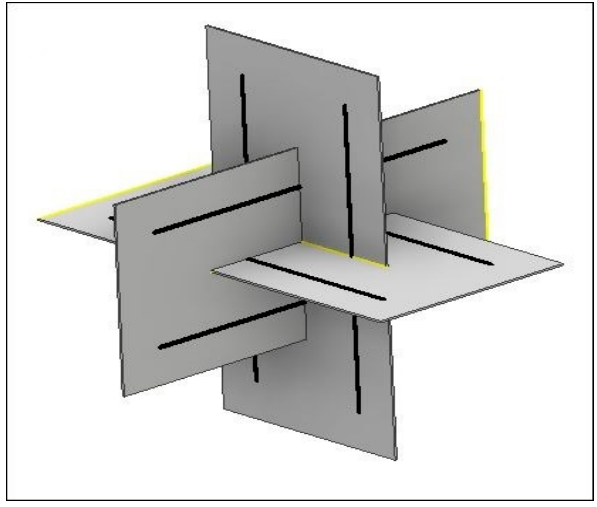
Figure 2. The struts of a tensegrity structure located in 3 mutually perpendicular planes. Both ends of the strut are located on the surface of the sphere. Chen et al. [7] modeled struts with a length of 12 µ m for simulating 12-strut tensegrity. In this research, we utilized bars with a length of 11.7 µ m in order to provide a better connection between the membrane and CSK.